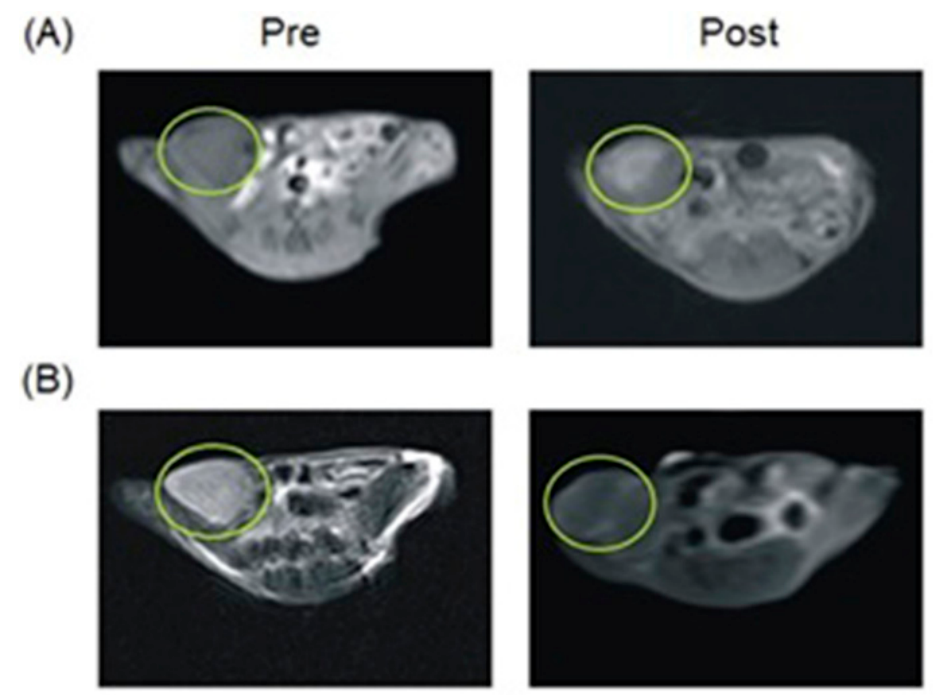
Figure 60. ( A ) T 1 -weighted and ( B ) T 2 -weighted MRI at 3.0 T of tumor-bearing mice before and after injection of nanoparticles. Yellow circles mark the tumor site. Adapted with permission [377]. The carbonic anhydrase IX enzyme is overexpressed in the hypoxic microenvironment in the tumor [69]. Xu, Ren, and co-workers reported albumin/sulfonamide-stabilized iron porphyrin metal-organic framework nanocomposites that target tumor hypoxia through accumulation in tumors overexpressing carbonic anhydrase IX [378]. Iron in the reported nanocomposite serves as a contrast agent for T 1 - and T 2 -weighted MRI ( r 1 = 2.7 mM − 1 s − 1 and r 2 = 19.68 mM − 1 s − 1 ). In vivo MRI ability of the nanocomposite was evaluated using a 4T1 tumor-bearing mouse. The results showed that the tumor location exhibited enhanced images relative to the pre-injection image (Figure 61). These results demonstrate that the nanocomposite-based T 1 / T 2 contrast enhancement generated in MRI can be used to image hypoxic regions in tumor sites [378].